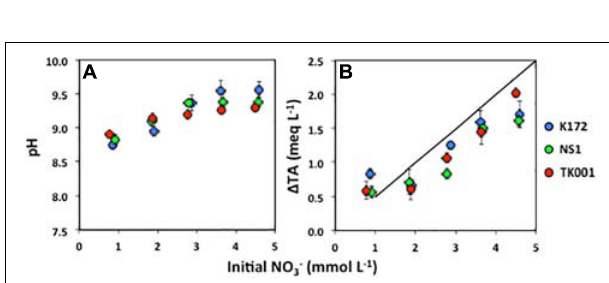
FIGURE 4 | (A) Final pH and (B) change in total alkalinity ( (cid:49) TA; meq L − 1 ) expressed as a function of initial NO 3 − concentrations (mmol L − 1 ) ( Table 4 ) produced through acetate oxidation coupled to denitrification by Thauera strains in batch cultures. Error bars represent standard errors for three to four